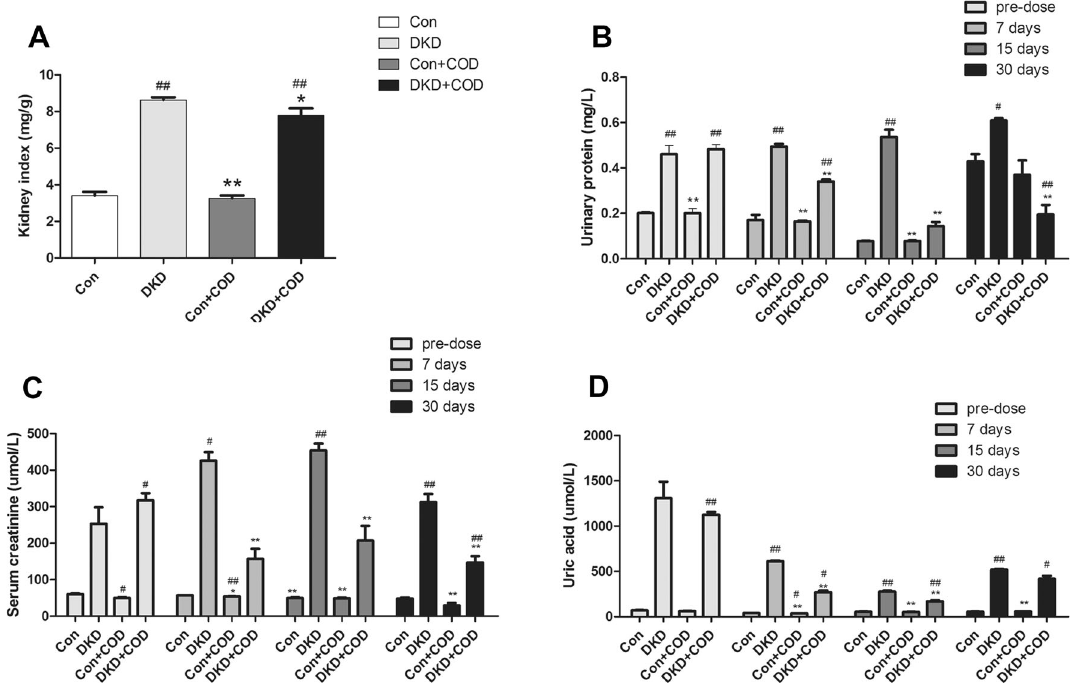
Fig. 2 Effect of COD on hypertrophy of remnant kidney and renal function in rats. The kidney index was calculated by using the remnant kidney to body weight ratio ( a ). Urinary protein content ( b ) of 12 h. Serum levels of serum creatinine ( c ) and uric acid ( d ). All